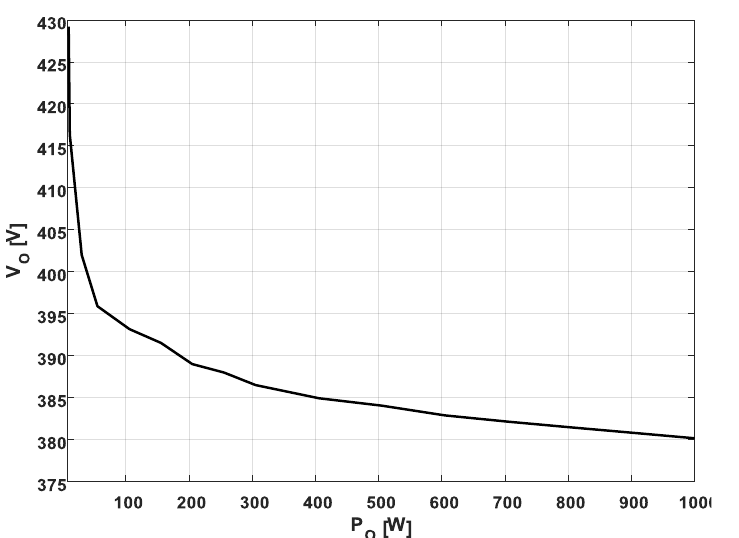
Figure 6. Measured output voltage versus load power [34].